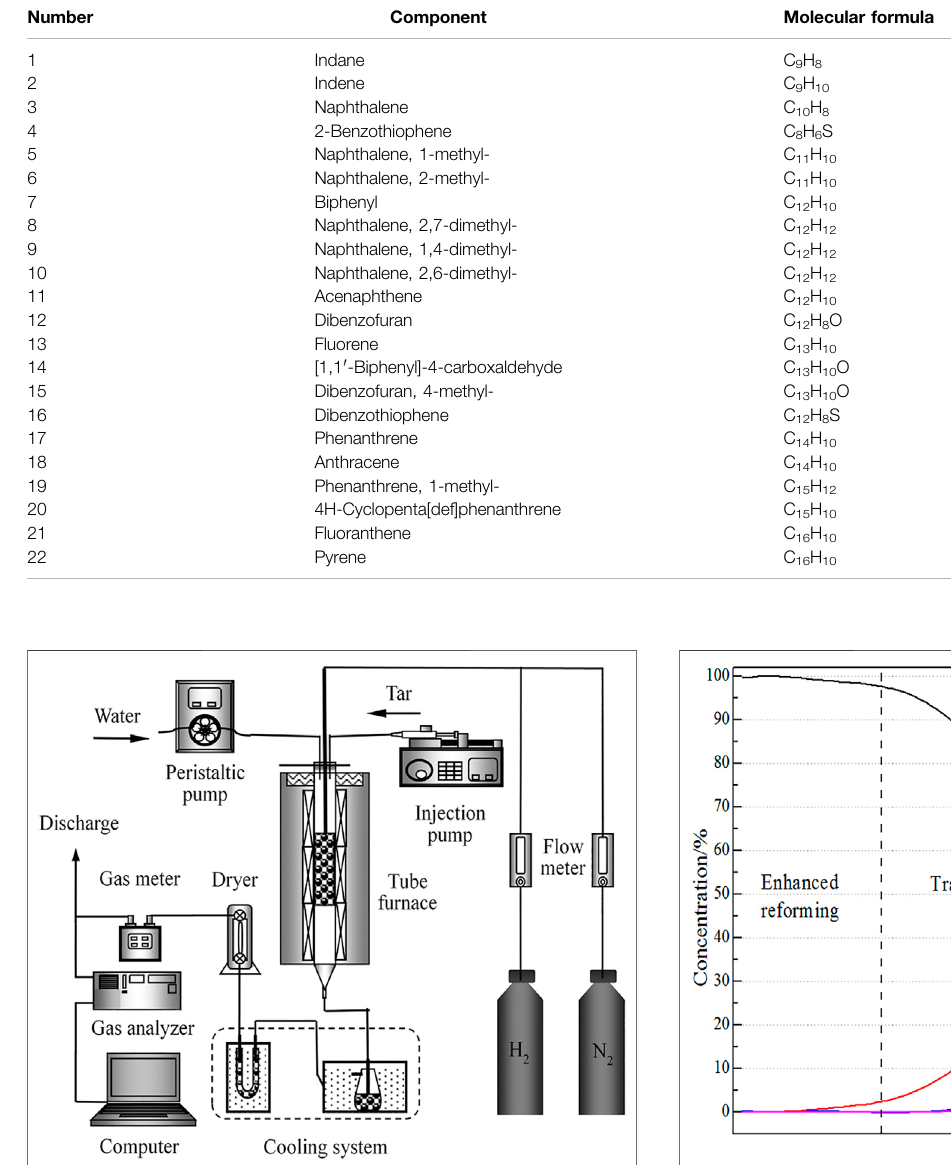
TABLE 1 | Constituent analysis of tar.